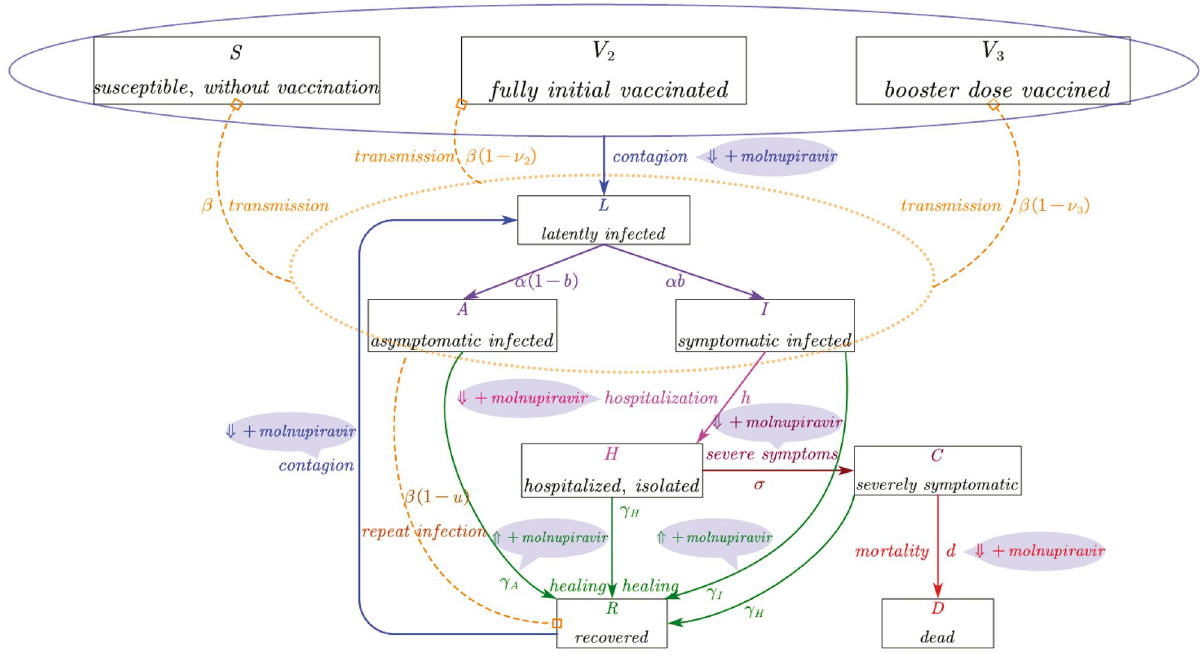
Figure 1. Schematic representation of the epidemiological model. In the mathematical compartment model: S, susceptible (uninfected, unvaccinated); V 2 , fully initial vaccinated (uninfected); V 3 , booster dose vaccinated (uninfected); L, latent (no symptom, with infectivity); A, asymptomatic carriers (infected, no symptom, with infectivity); I, symptomatic patients (actively infected with symptom, with infectivity); H, hospitalized (actively infected with symptoms, quarantined); C, Severe symptomatic (actively infected with severe symptoms, life-threatening, hospitalized, quarantined); R, recovered (healed, might be reinfected); D, dead (extinct). In this model, asymptomatic carriers mean asymptomatic infections who never develop symptoms but not pre- symptomatic infections who eventually develop into symptomatic